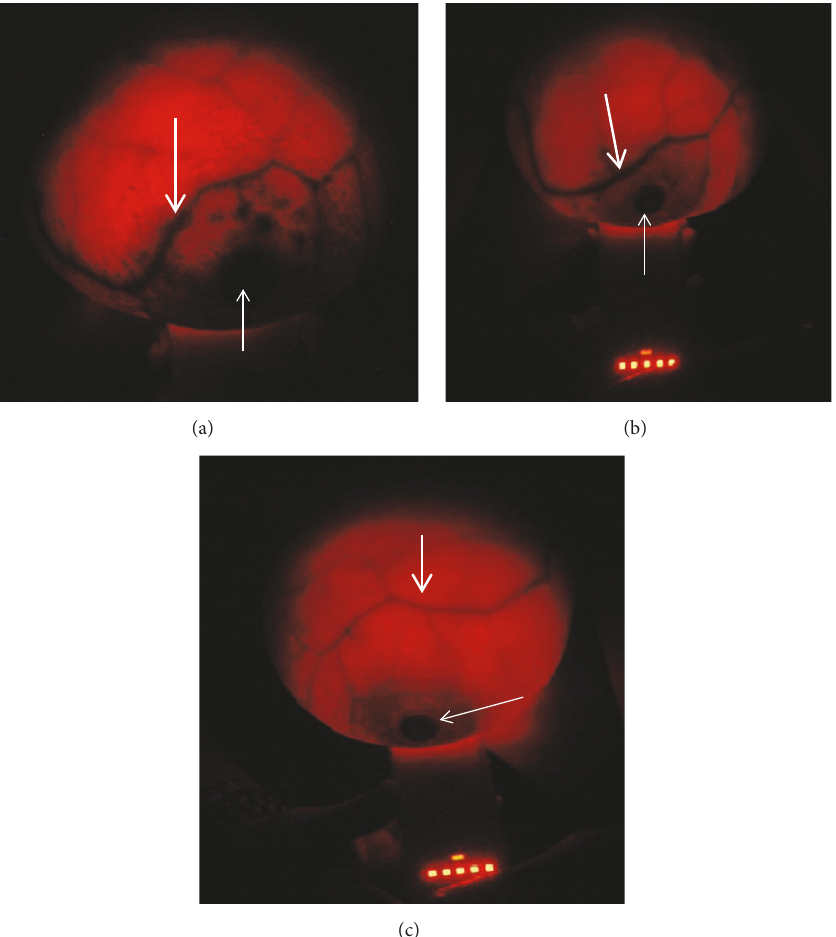
Figure 3: Breast-i images of the breasts of three participants . The thick arrows show the vein pattern of the right breast of a 46-year-old participant (a), 30-year-old participant (b), and 20-year-old participant (c). The thin arrows show the circular area around the nipples which isnormallydarkduetonormalpigmentationoftheareola.Breastsinboththe30and20yearoldsweredenseandrequiredmaximumintensity light for visualization. These breasts are normal and devoid of any suspicious